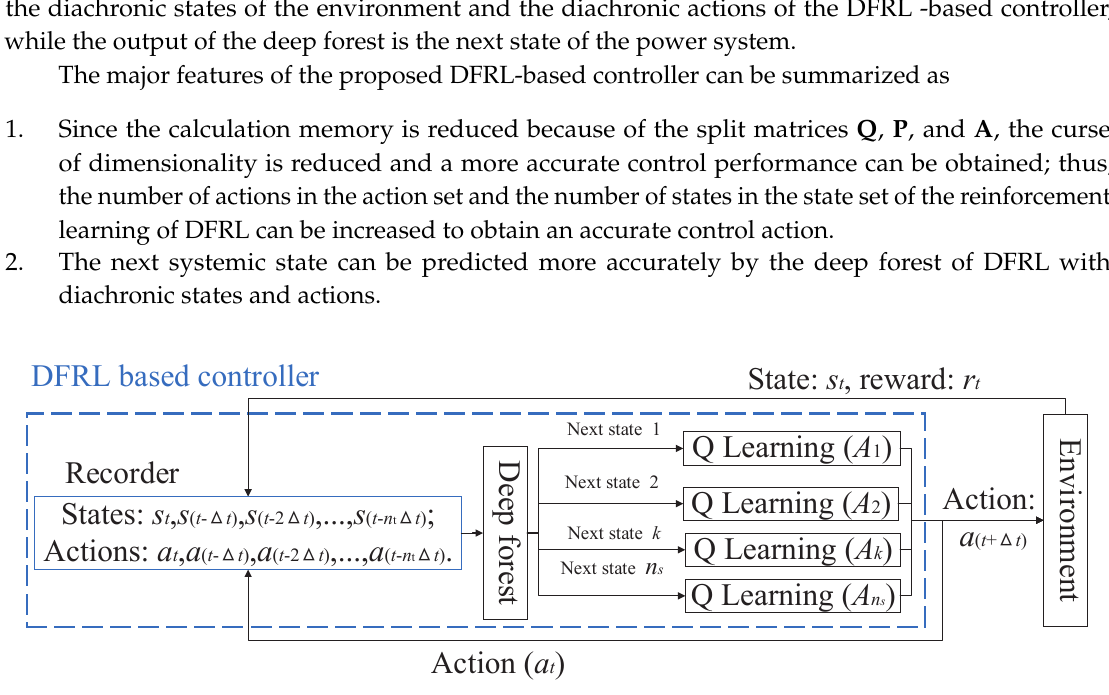
Figure 4. Structure of deep forest reinforcement